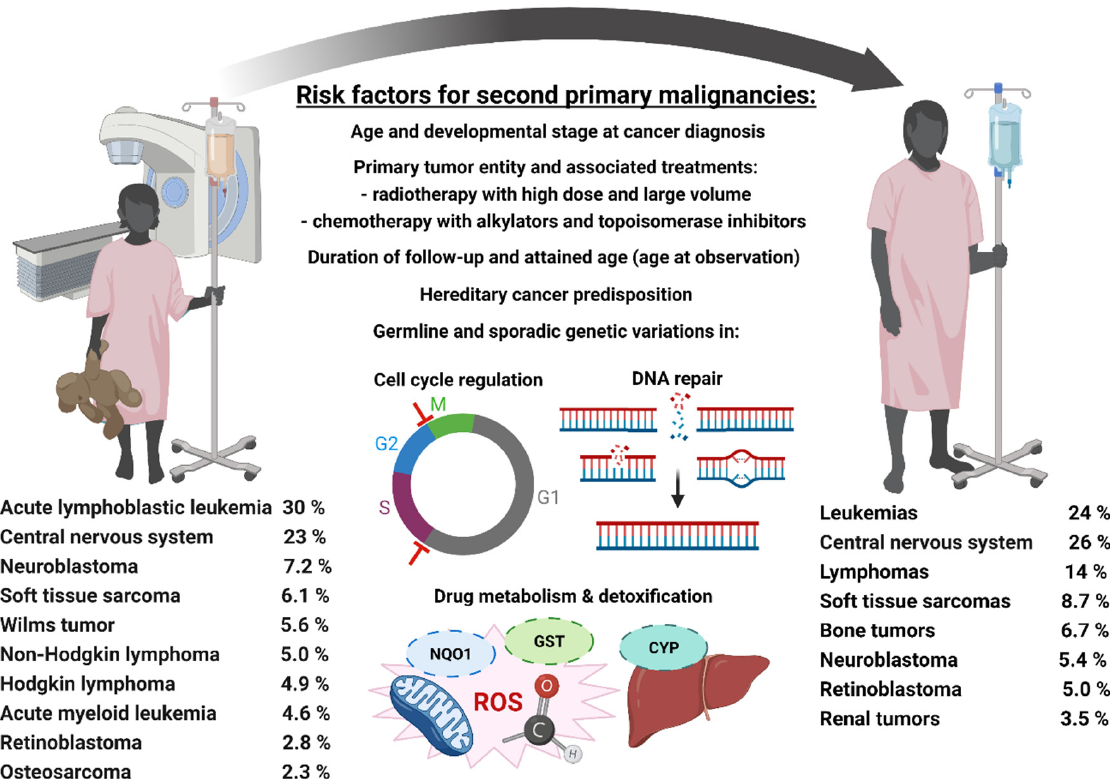
Figure 1. Pediatric first primary malignancies and risk factors for the development of second primary malignancies. The fractions of the most common pediatric first primary malignancies and second primary malignancies in childhood cancer survivors among all observed cancers are provided [11,88,89]. Abbreviations : DNA, deoxyribonucleic acid; NQO1 Nicotinamide adenine dinucleotide phosphate: quinone oxidoreductase; GST, Glutathione s-transferase; CYP, Cytochrome P450.